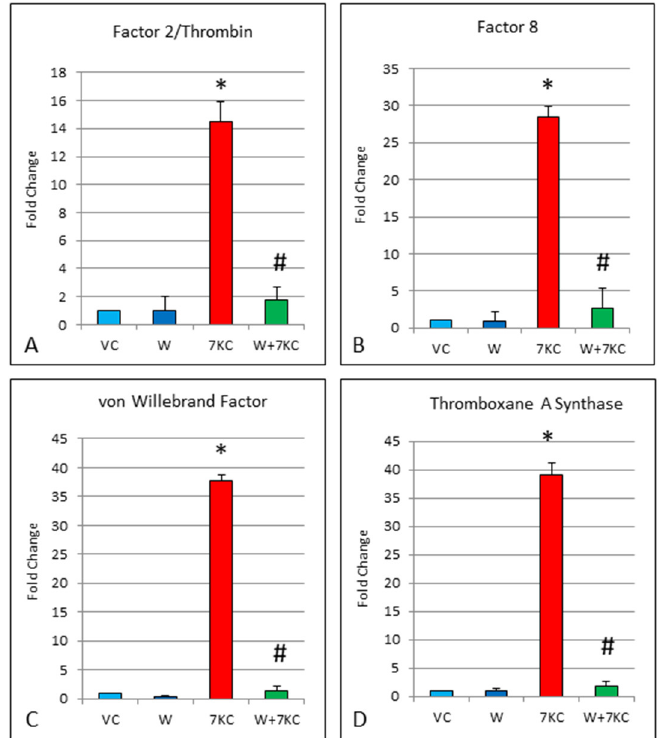
Figure 6. ( A – D ) Effect of withanolide A on 7KC-induced increase in mRNA expression of clotting genes, determined by real time RT-PCR. hCMEC/D3 cells were pre-treated with 1 μM withanolide A for 1 h, followed by co-incubation with 30 μM 7KC for 24 h. Treatment of cells with 7KC resulted in significant induction of Factor 2/thrombin, Factor 8, von Willebrand factor and thromboxane A synthase mRNA expression. These increases were significantly reduced by withanolide A. Data are represented as mean ± SD ( n = 4). * Significant difference compared to controls. # Significant difference compared to 7KC (all p < 0.01).